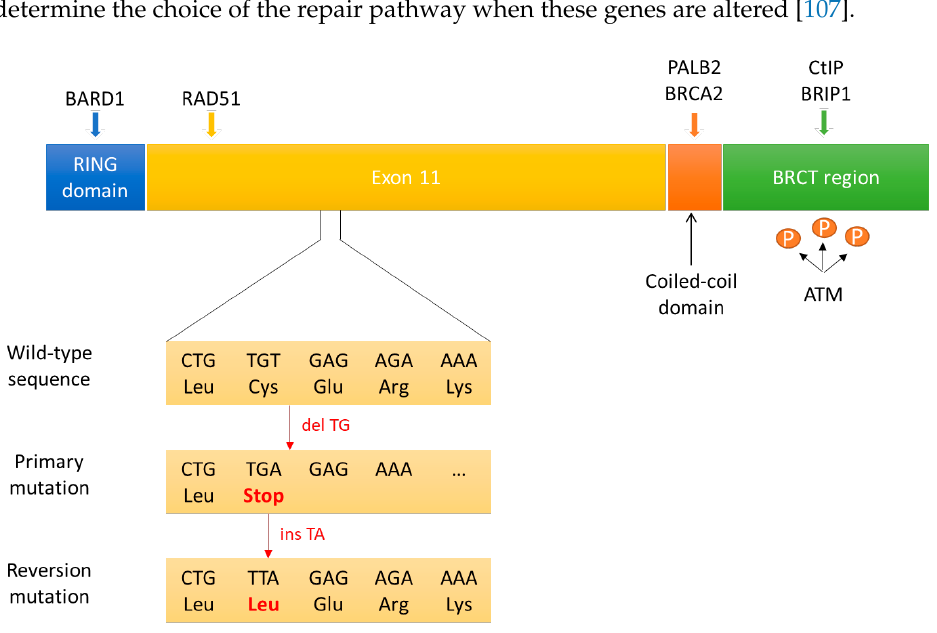
Figure 3. BRCA1 structural domains and reversion mutations. BRCA1 is a multi-domain protein. The N-terminal RING domain mediates interactions between BRCA1 and BARD1. Some N-terminal BRCA1 mutations may result in RING-less BRCA1 protein that could retain some residual activity in DNA damage response, conferring resistance to PARPi. The coiled-coil domain associates with PALB2 and BRCA2. The C-terminal domain (BRCT) contains potential ATM phosphorylation sites and can bind CtIP and BRIP1. C-terminal truncated BRCA1 proteins can be semifunctional, retaining the protein domains necessary to mediate interactions with PALB2-BRCA2-RAD51. Most amino acid sequences encoded by exon 11 are essential with regard to the protein function and for binding important HR proteins including RAD51. BRCA1 mRNA isoforms originated by alternative splicing and lacking exon 11 can produce truncated but hypomorphic proteins that have residual BRCA1 function. Primary mutations are mostly deletions causing frameshifts, leading to premature STOP codons. Reversion mutations in these cases are deletions or insertions (as in the example above), leading to the restoration of the BRCA open reading frame and functional